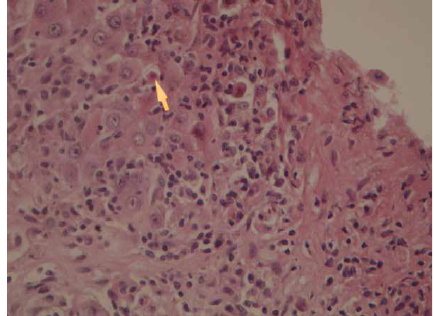
Figure 1: Liver biopsy showing Interface hepatitis revealing spillover of inflammation into adjacent liver parenchyma and necrotic hepatocytes. HE 10 × 20.